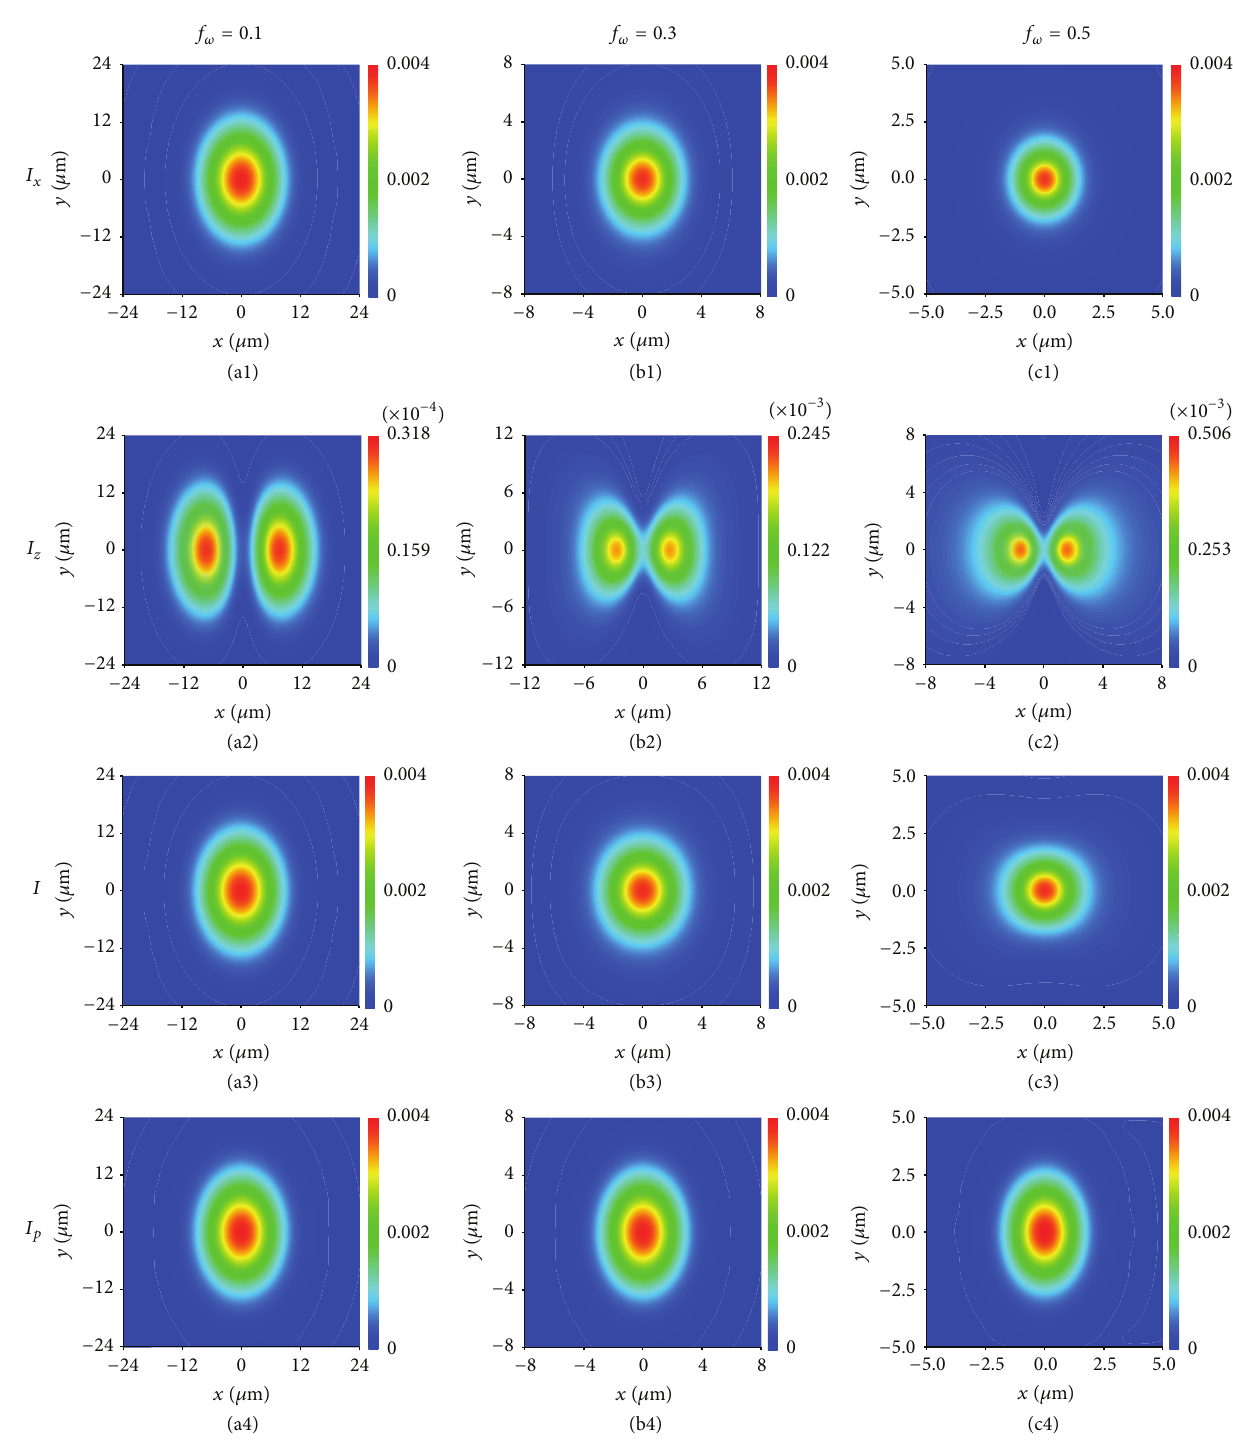
Figure 4: Contour graphs of intensity distributions 𝐼 𝑥 (𝑥,𝑦,𝑧), 𝐼 𝑧 (𝑥,𝑦,𝑧) , 𝐼(𝑥, 𝑦,𝑧) , and 𝐼 𝑝 (𝑥,𝑦,𝑧) of elliptical Gaussian beam with elliptic coefficient 𝛼 = 1.5 in the plane 𝑧 = 10𝑧 𝑟 for different parameters 𝑓 𝜔 : (a1)–(a4) 𝑓 𝜔 = 0.1 ; (b1)–(b4) 𝑓 𝜔 = 0.3 ; (c1)–(c4) 𝑓 𝜔 = 0.5 .